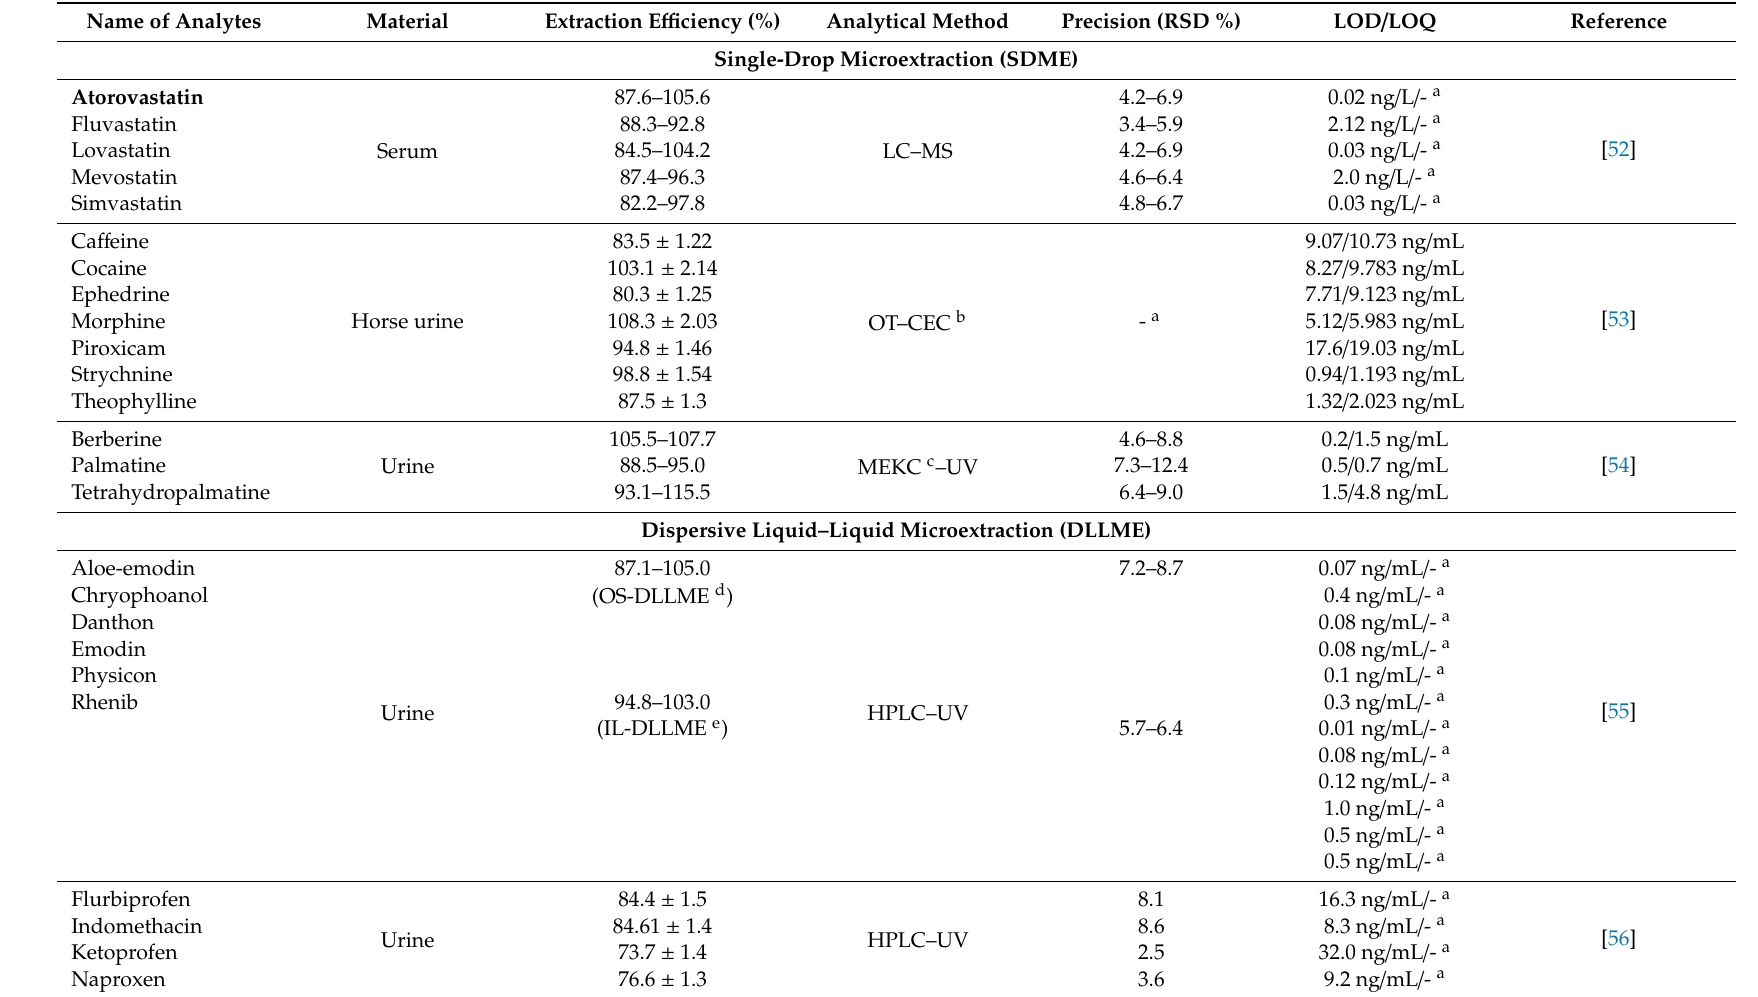
Table 2. Methods of sample preparation by liquid-phase